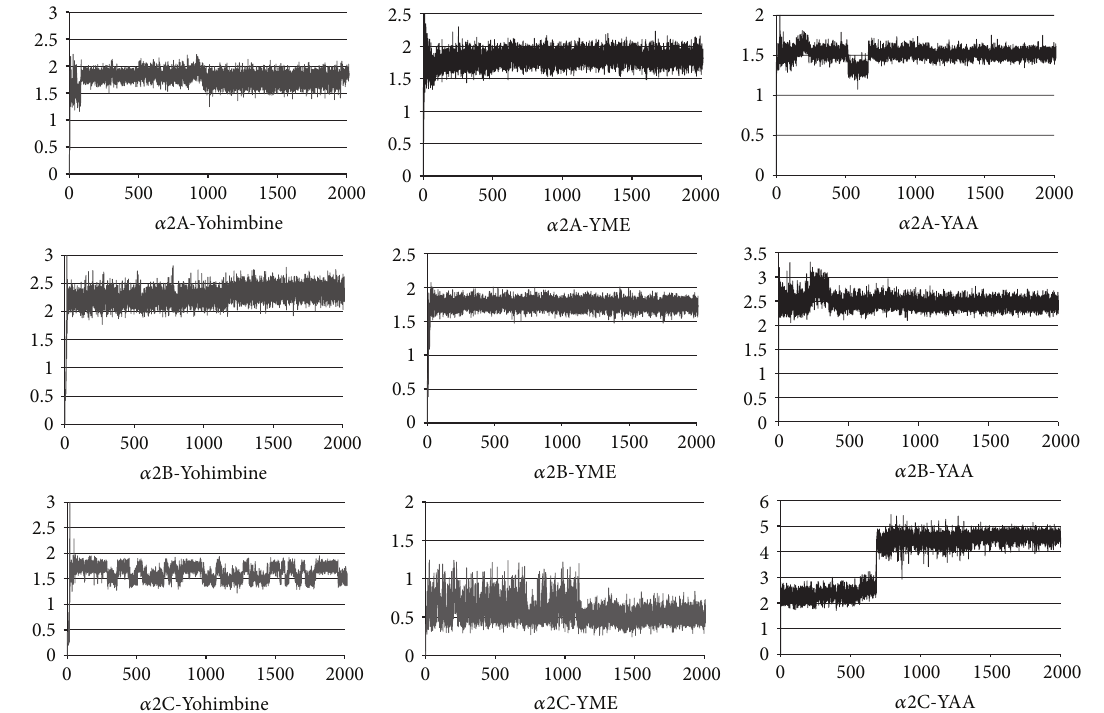
Figure 4: The RMSD fluctuation during MD simulation.